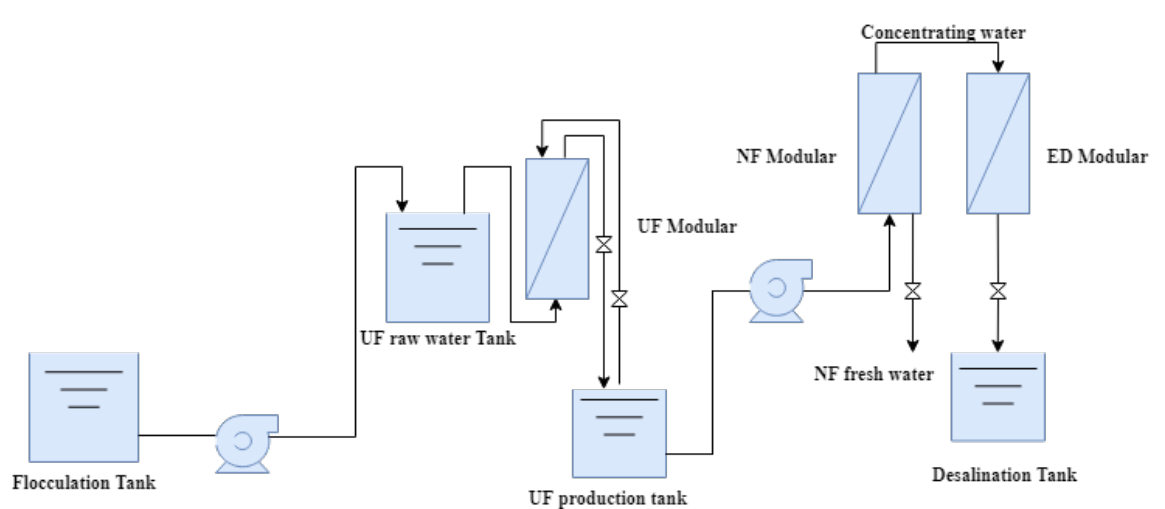
Figure 1. Process flow chart of tanning chromium removal wastewater treatment.